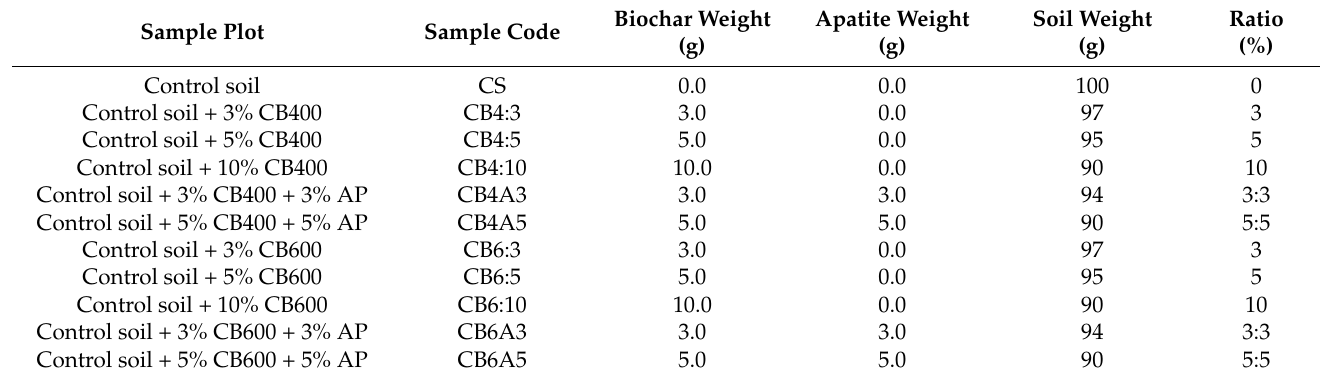
Table 5. Designation of the incubation